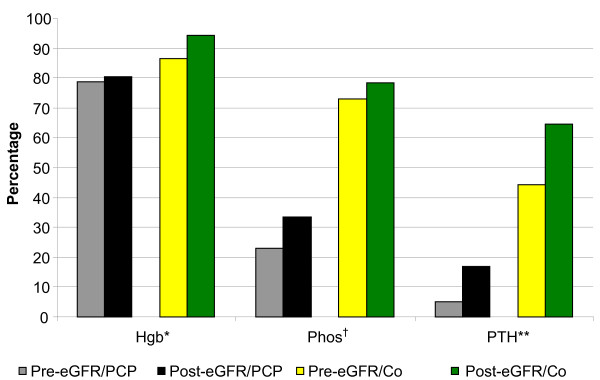
Laboratory processes of care for CKD 3b-4 patients.Pre-eGFR cohort: n=274, Post-eGFR cohort: n=266.* Post-eGFR/PCP vs. Post-eGFR/Co, P=0.001.†Pre-eGFR/PCP vs. Post-eGFR/PCP, P=0.03; Pre-eGFR/PCP vs. Pre-eGFR/Co, P<0.0001; PosteGFR/  PCP vs. Post-eGFR/Co, P<0.0001.**Pre-eGFR/PCP vs. Post-eGFR/PCP, P=0.0001; Pre-eGFR/Co vs. Post-eGFR/Co, P=0.02; PreeGFR/  PCP vs. Pre-eGFR/Co, P<0.0001; Post-eGFR/PCP vs. Post-eGFR/Co, P<0.0001.  Hgb hemoglobin, Phos phosphorus, PTH parathyroid hormone, eGFR estimated glomerular  filtration rate, PCP primary care physician managed, Co co-managed.